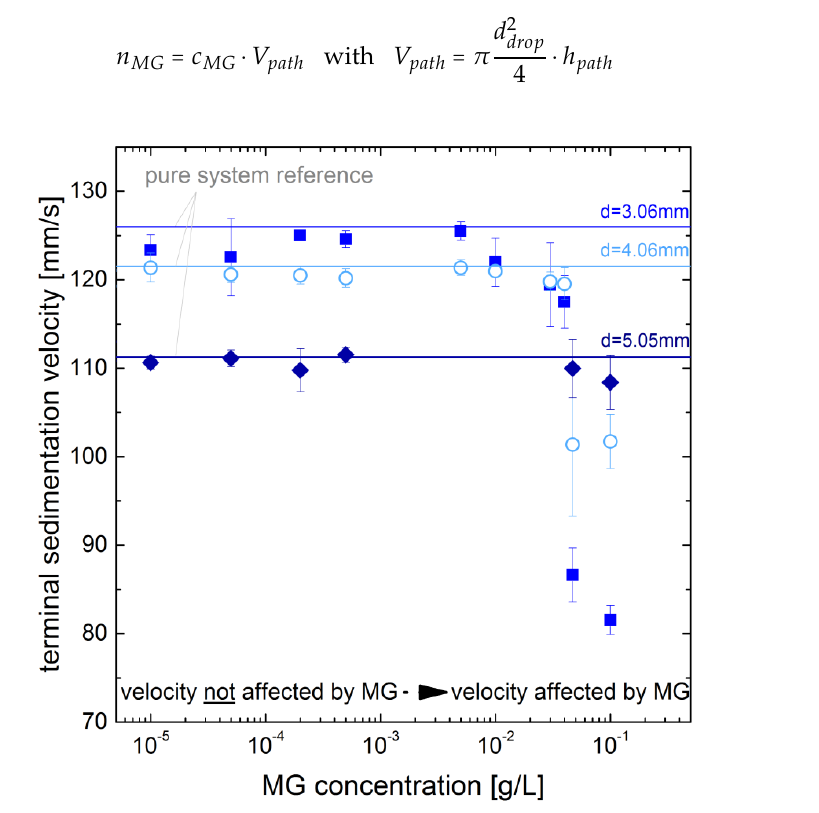
Figure 5. Impact of microgel concentration of MG4 in the drop generator on sedimentation velocity for different drop diameters (lines indicate pure system